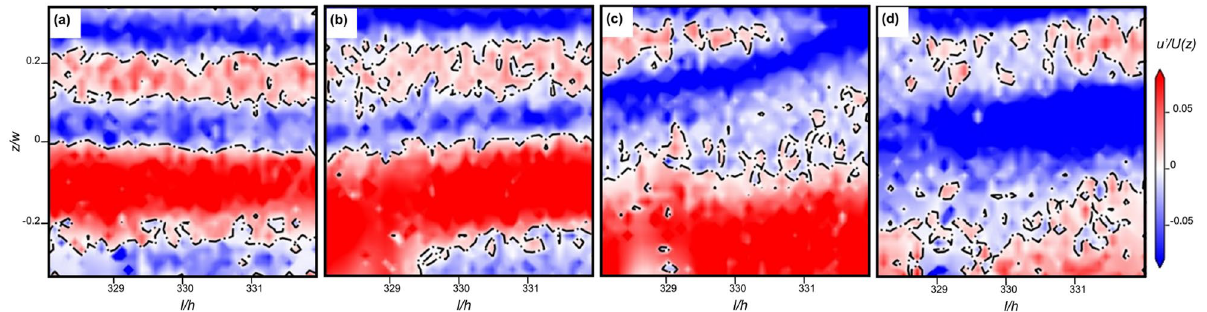
Figure 4. Streak interface dynamics at l / h =330 and Wi =2030 in ET during a single cycle. The images present the instant normalized stream-wise velocity fluctuations, obtained by subtraction from a fully measured stream- wise velocity field and normalized by mean velocity, u ′ / U ( z ) . The black dashed lines of u ′ / U ( z ) = 0 separate negative (blue) and positive (red) streaks. The images shown at four normalized times t ∗ = tf el from left to right are 0.20, 0.38, 0.65, and 0.92. The streak interface is gradually disturbed and destroyed resulting in random flow at the cycle end without any secondary instability. Then the next cycle